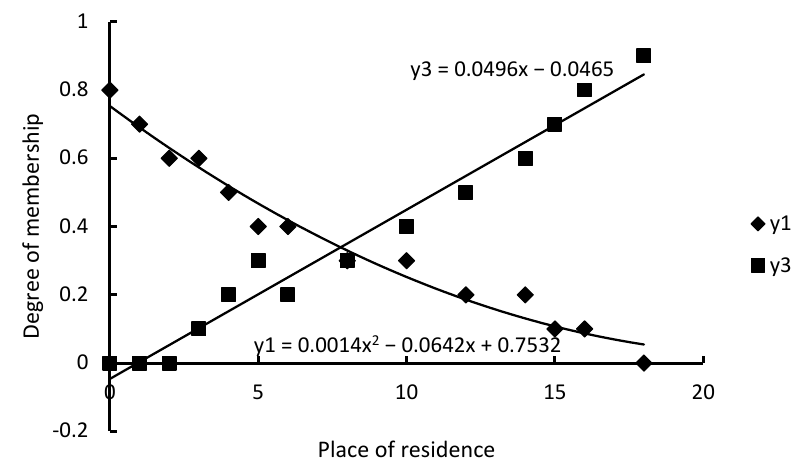
Figure A2. Single factor evaluation for the index of place of residence.